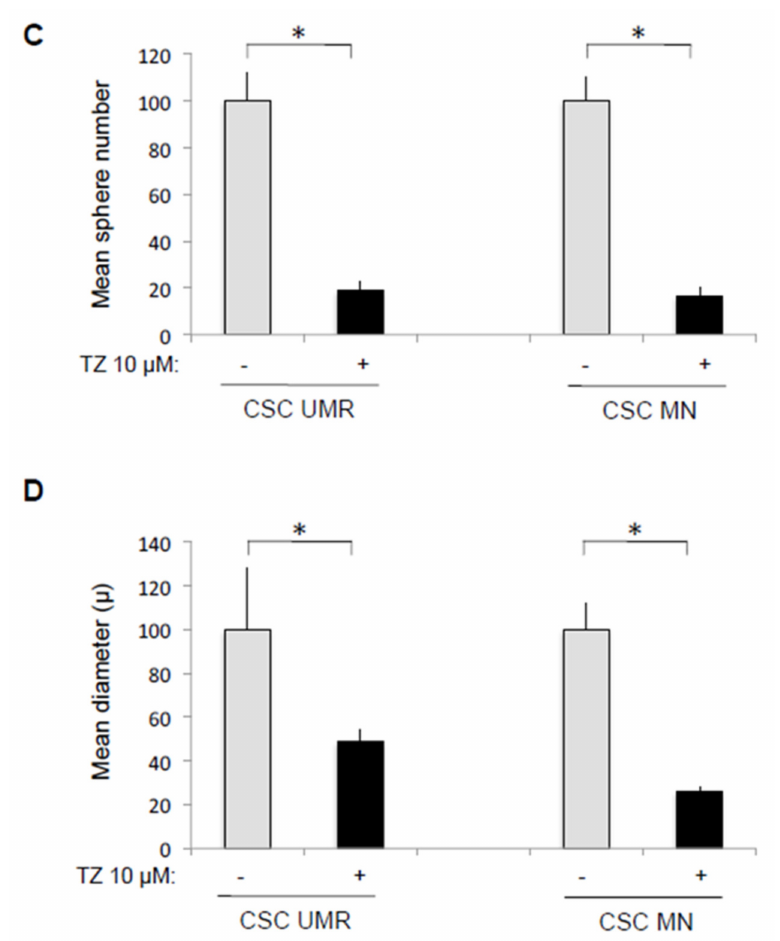
Figure 6. TZ inhibiting OS sphere formation. ( A , B ) Sphere formation in the absence (Control, C) or in the presence of TZ at 10 µ M. Representative photographs at 24, 72 h (magnification × 5) and 120 h (magnification × 40). ( C ) Mean sphere number at 120 h normalized to control in each condition. ( D ) Mean diameter at 120 h normalized to control in each condition. * p < 0.05 (Student t